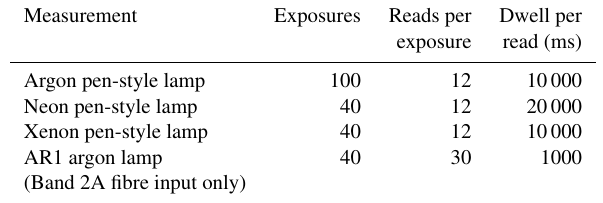
Table 3. Measurements used for the spectral calibration of GHOST (see text in Sect. 3.3).